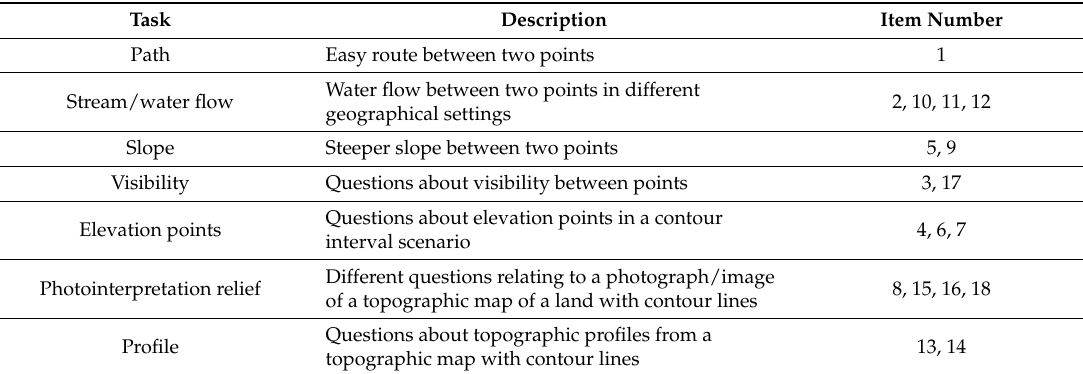
Table 1. Topographic Map Assessment